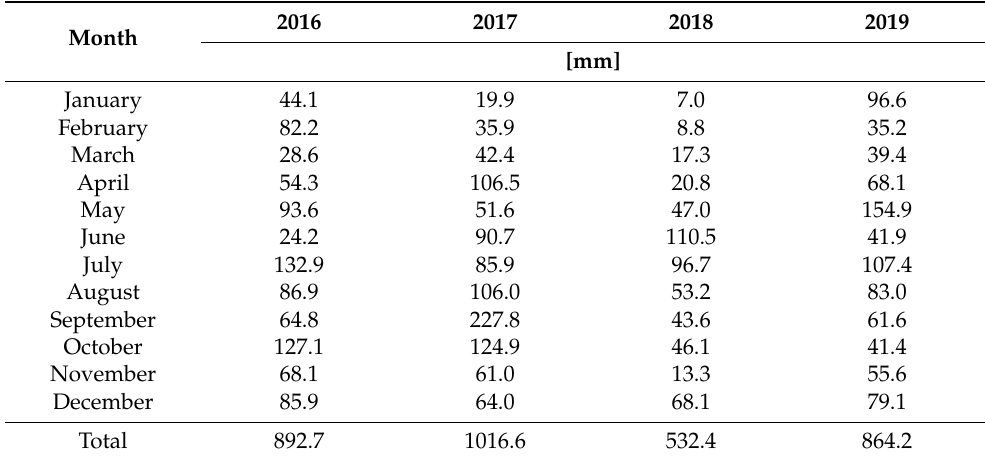
Table 1. Monthly and annual precipitation amounts in the analyzed sewage system in Nowy